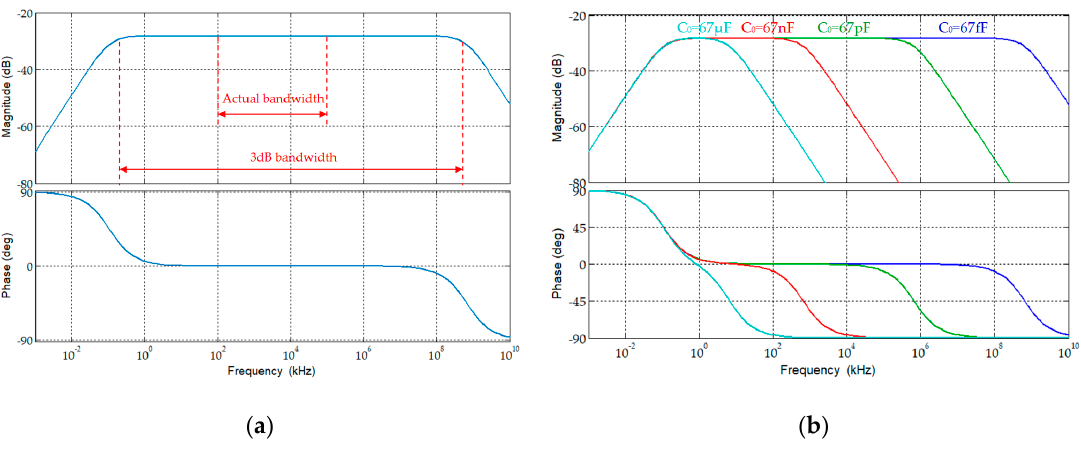
Figure 16. Frequency response of the D-HFCT sensor. ( a ) C 0 = 67 fF ; ( b ) C 0 increases.